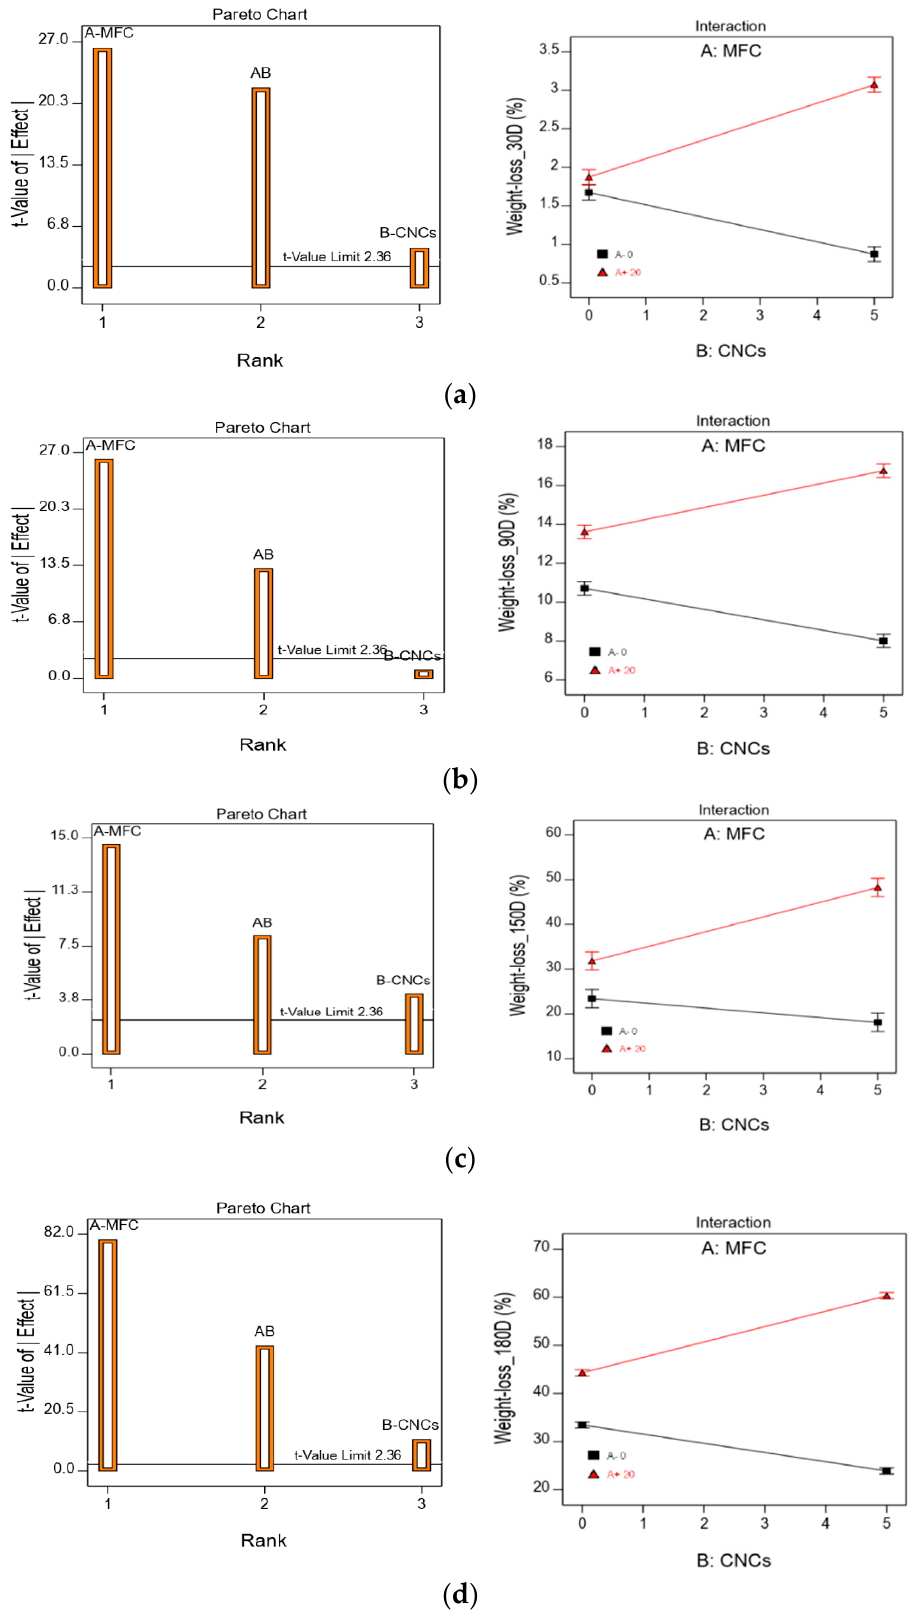
Figure 8. Pareto and interaction graphs for HBCs weight loss for ( a ) 30 D; ( b ) 90 D; ( c ) 150 D; and ( d ) 180 D incubation